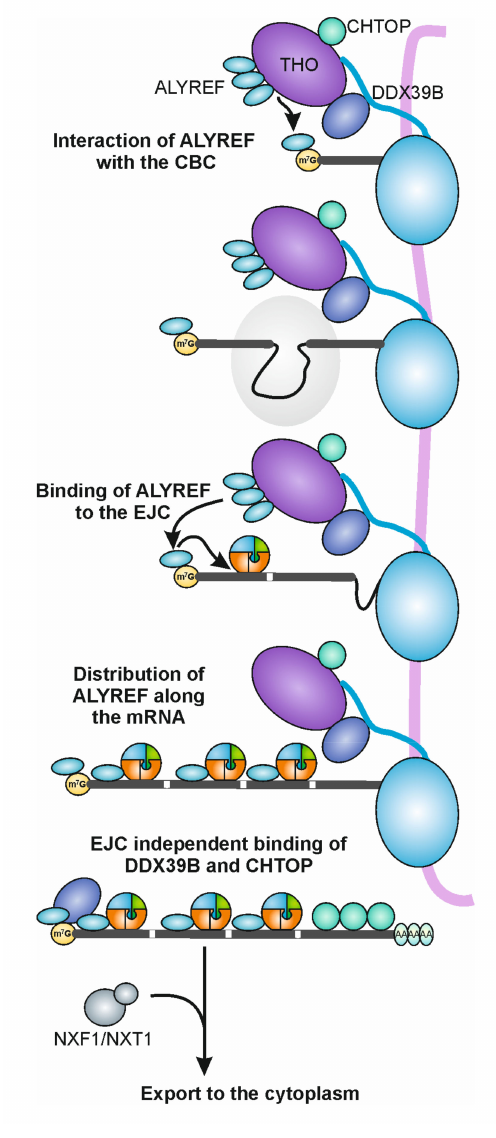
Figure 3. Recruitment of mRNA export factors by the EJC. The TREX complex (THO, DDX39B, ALYREF) interacts with the CTD of Pol II. The mRNA export factor ALYREF is first recruited to the CBC and in a next step distributed on the mRNA upstream of canonical EJC positions by an interaction with the EJC component EIF4A3. DDX39B and CHTOP bind in an EJC-independent manner to the cap binding complex (CBC) and the 3 (cid:48) UTR of the mRNA, respectively. When all export factors are deposited and polyadenylation is completed, the export receptors NXF1 / NXT1 are recruited and promote export of the